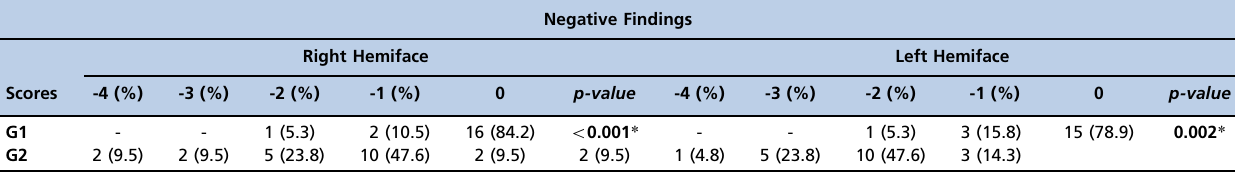
Table 5 - Evaluation of negative facial findings in deep partial-thickness burns – G1 (n=19) and full-thickness burns – G2 (n=21) Negative Findings Right